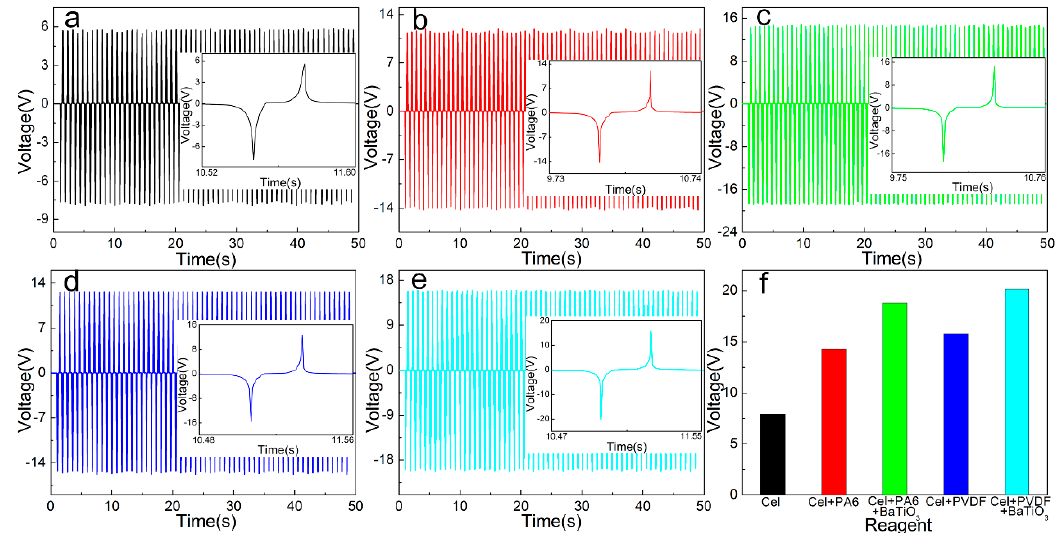
Figure 5. Output voltage of a single different type of friction layer: ( a ) Cel, ( b ) Cel + PA6, ( c ) Cel + PA6 + BaTiO 3 , ( d ) Cel + PVDF, ( e ) Cel + PVDF + BaTiO 3 , ( f ) maximum instantaneous value.